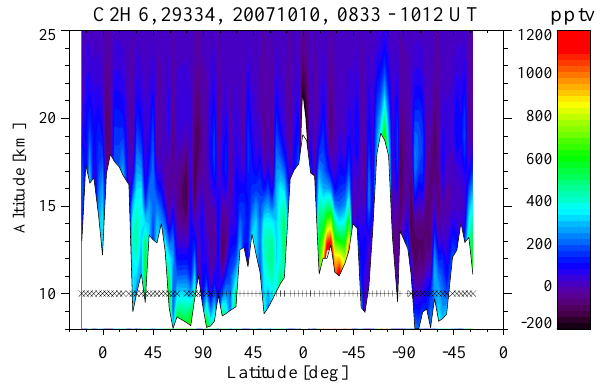
Fig. 9. Single orbit measurements of C 2 H 6 vmr. Mixing ratios are plotted versus altitude and latitude. “x”-symbols represent night- ime, while “+”-symbols are daytime measurements.